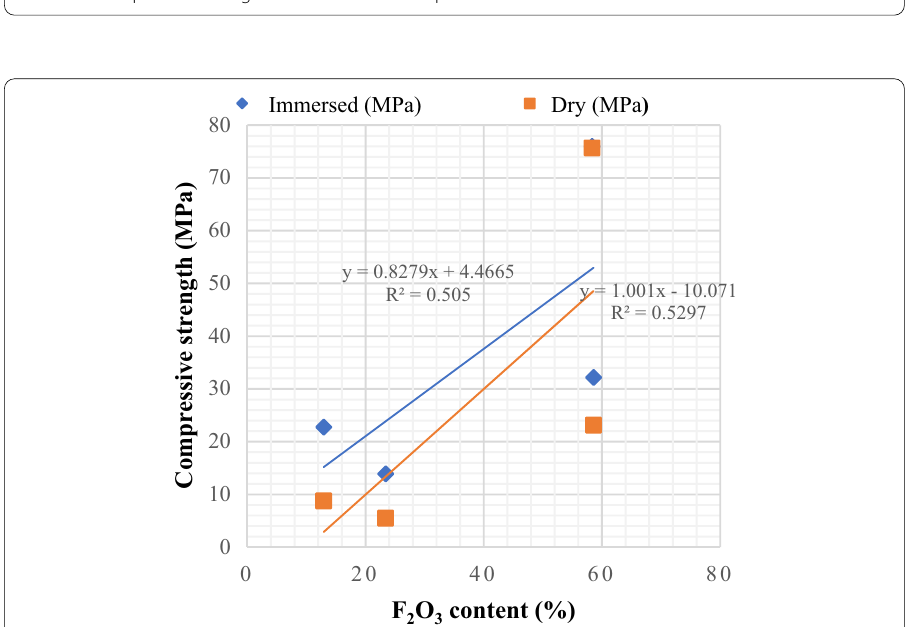
Fig. 9 Influence of F 2 O 3 content on dry and immersed compressive